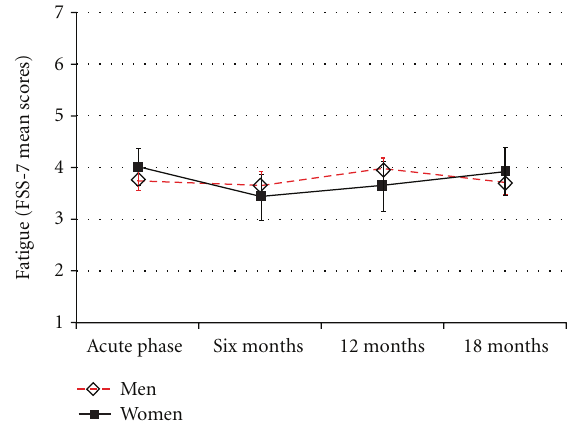
Figure 1: Time course for fatigue among men ( n = 56) and women ( n = 39). Adjusted for level of physical functioning, depressive symptoms, and prestroke fatigue. Bars are lower and upper 95% CI.